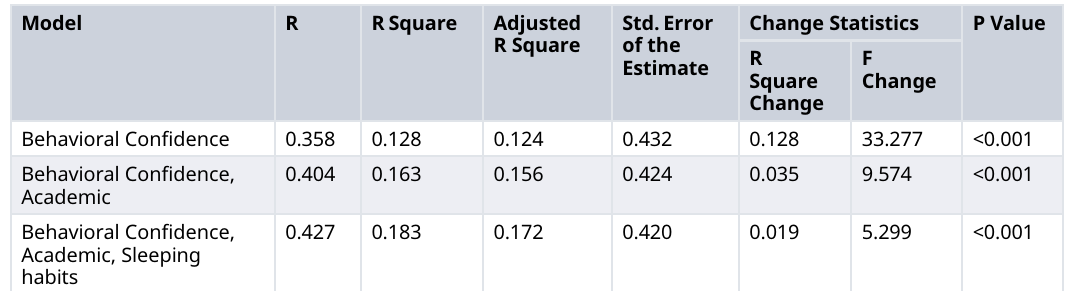
Table 4. Hierarchical regression analysis of factors effecting twice daily brushing (dependent variable) and independent variables from demographic variables, multi theory model domains, personality inventory and sleeping